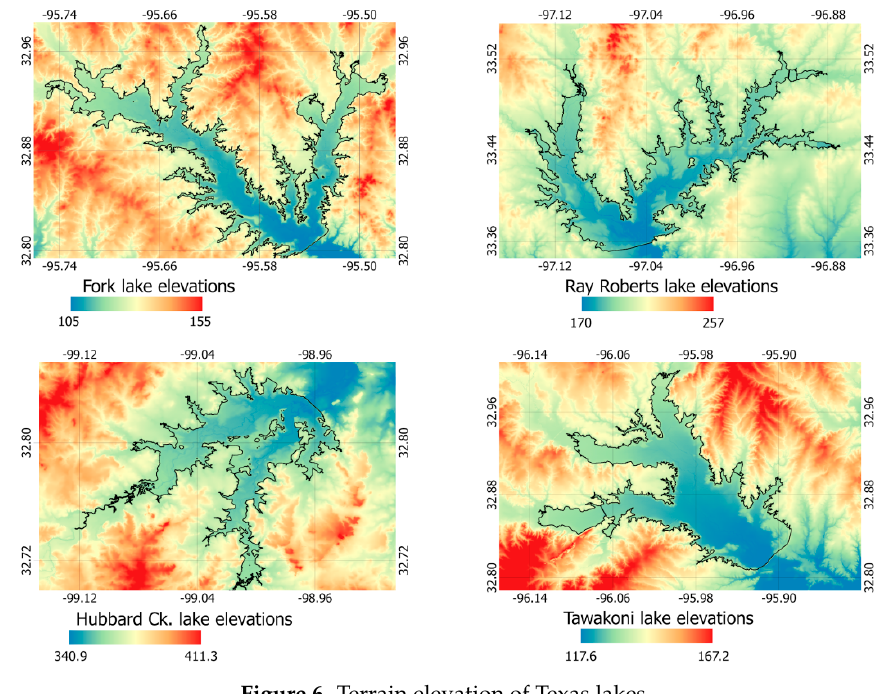
Figure 5. Terrain elevation of Oklahoma lakes.